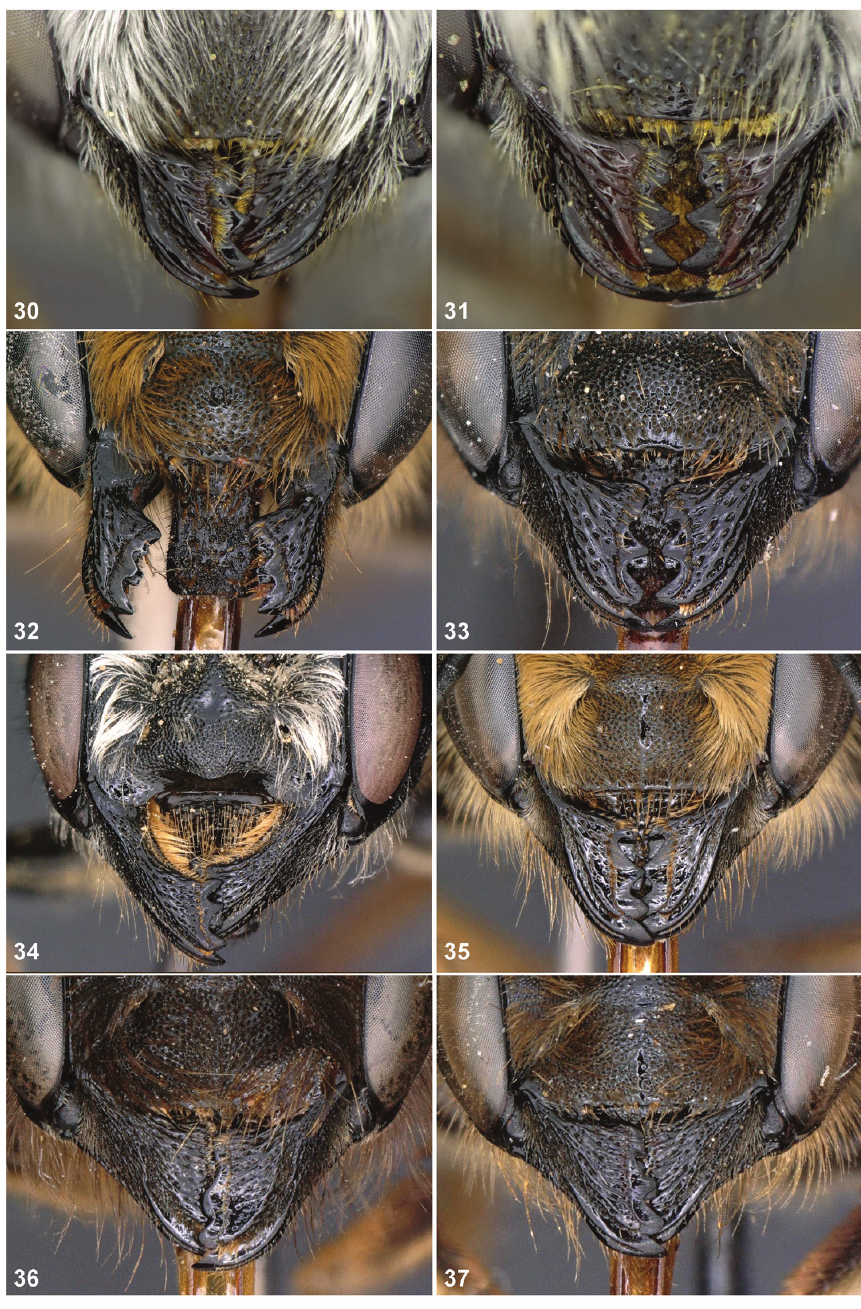
Figures 30–37. Female clypeus and mandibles, front view. 30 Megachile ( Anodonteutricharaea ) albo- hirta 31 M. ( Anodonteutricharaea ) thevestensis 32 M. ( Megachile ) versicolor 33 M. ( Megachile ) lapponica 34 M. ( Megachile ) bombycina 35 M. ( Xanthosarus ) lagopoda 36 M. ( Xanthosarus ) nigriventris 37 M. ( Xan- thosarus ) willughbiella